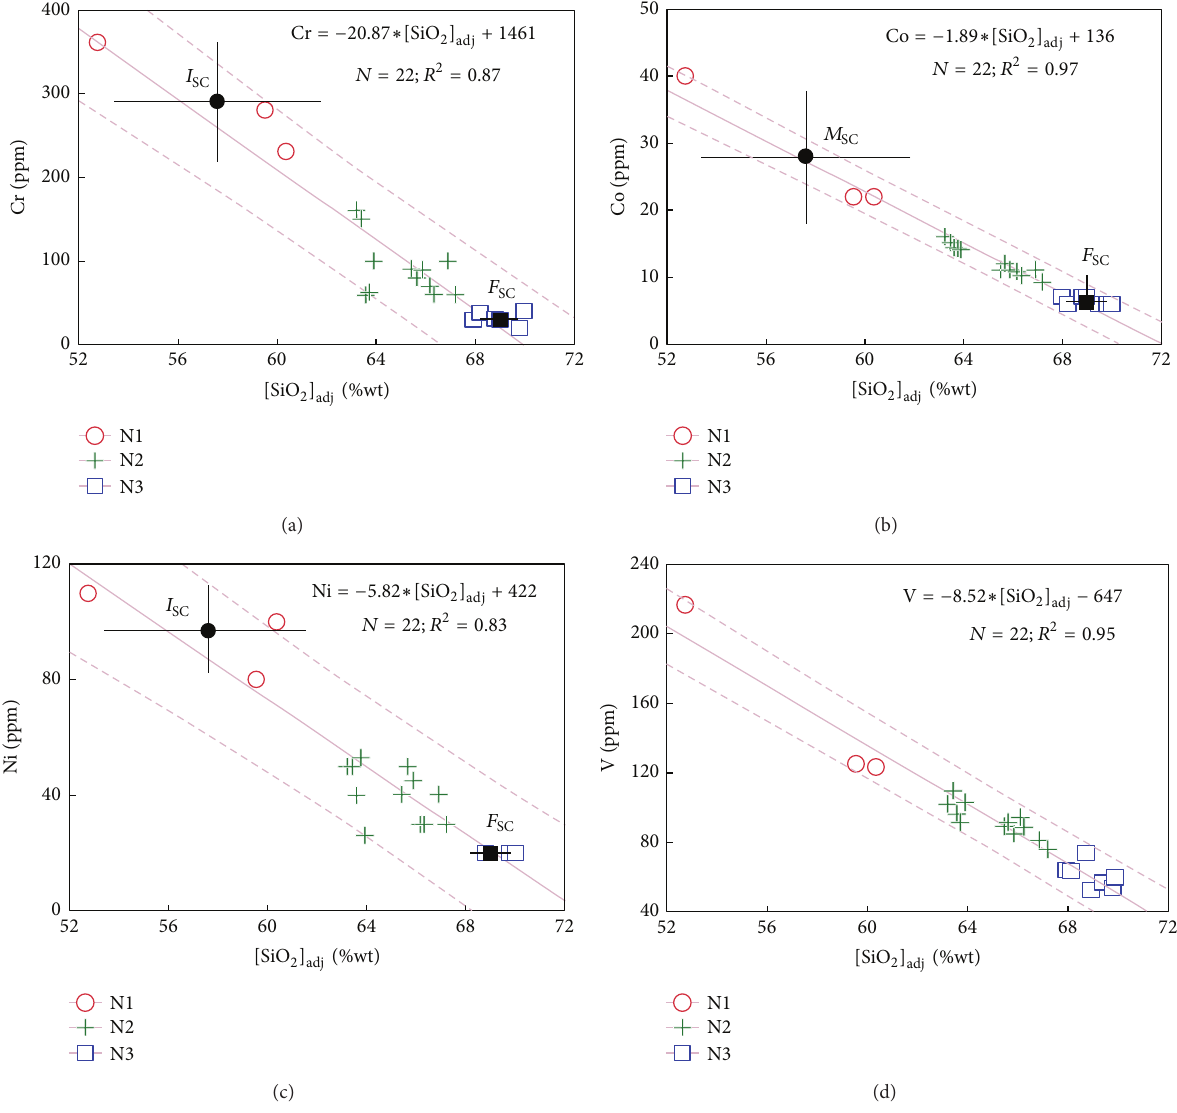
Figure 12: Trace element Harker-type diagrams for volcanic rocks from the Sierra de las Cruces northern sector. OLS regression models as those presented in Figure